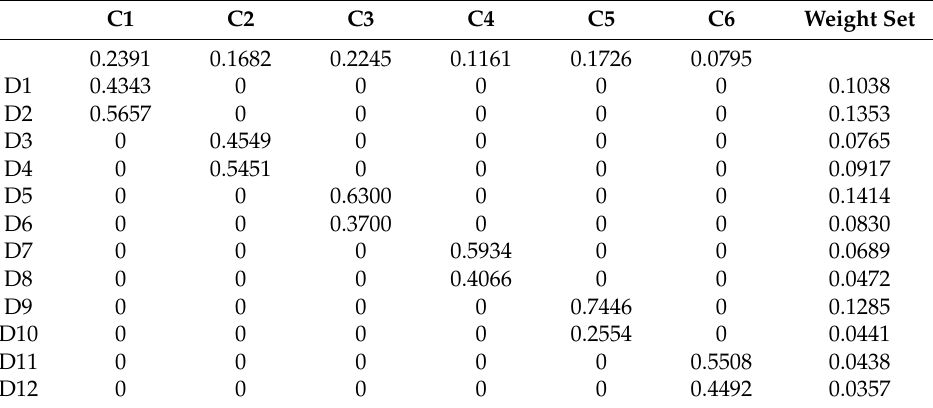
Table 8. The weight set calculation for the D level.